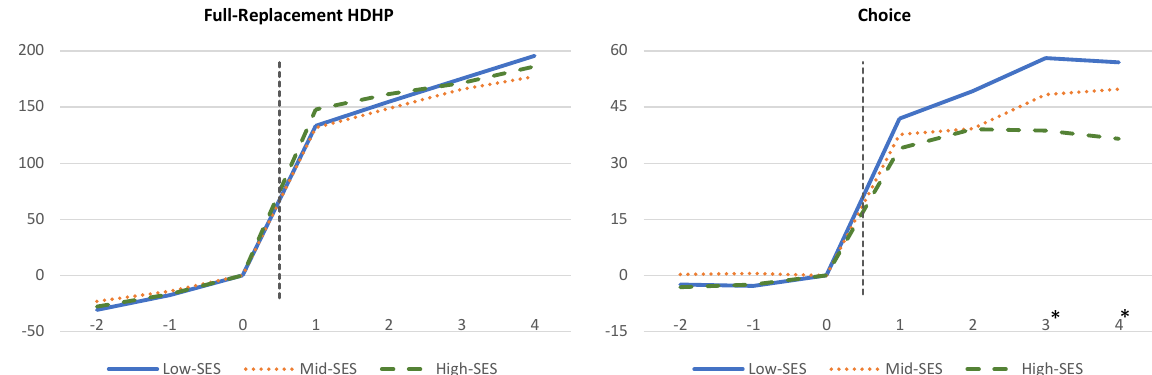
Figure 8: Triple-difference estimates comparing effects of choice devolution and full-replacement transition to high-deductible plans on differential changes in OOP burden by SES, with inverse probability weighting adjustment. Notes: This figure shows estimates from triple difference models of the effects of alternative transitions on OOP expenditures. The sample includes enrollees at all firms that either undergo a mandated transition to all high-deductible plans or transition to devolved choice of insurance deductible level at some time during the study period. SES categories correspond to the bottom 25 percent, middle 50 percent, and top 25 percent of the sample distribution. The model is estimated with year-fixed effects and with person-fixed effects centered at the pre-devolution level. Because firms’ decisions to elect full replacement versus choice may depend in part on the health risk profiles of their employees, we applied inverse probability weighting using weights derived from a firm-level probit model of transition type on demographic and health risk characteristics of their enrollee pool. ∗ indicates a statistically significant difference between the high- and low-SES groups at p <